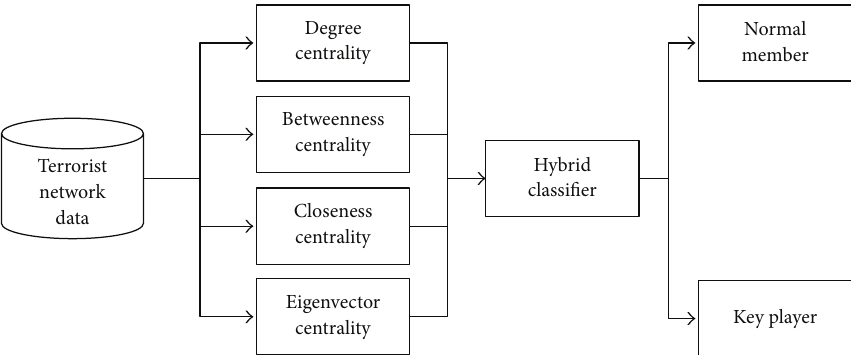
Figure 3: Proposed framework for key player